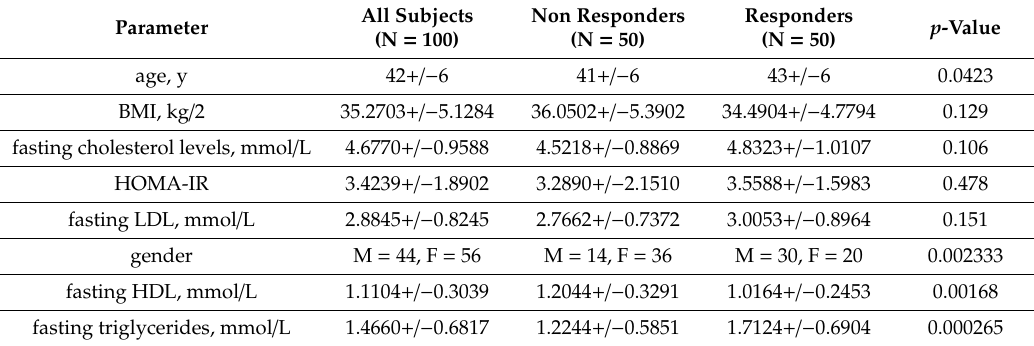
Table 1. Baseline characteristics of selected patients. Numbers represent the mean and standard deviation. For gender, the p -value was obtained from a two-sided Fisher’s exact test; for all other parameters, the p -value was obtained from a two-sided t -test. All parameters are representative of the whole DiOGenes cohort, including recent observations made from deep phenotyping analyses of 174 responders and 201 non-responders